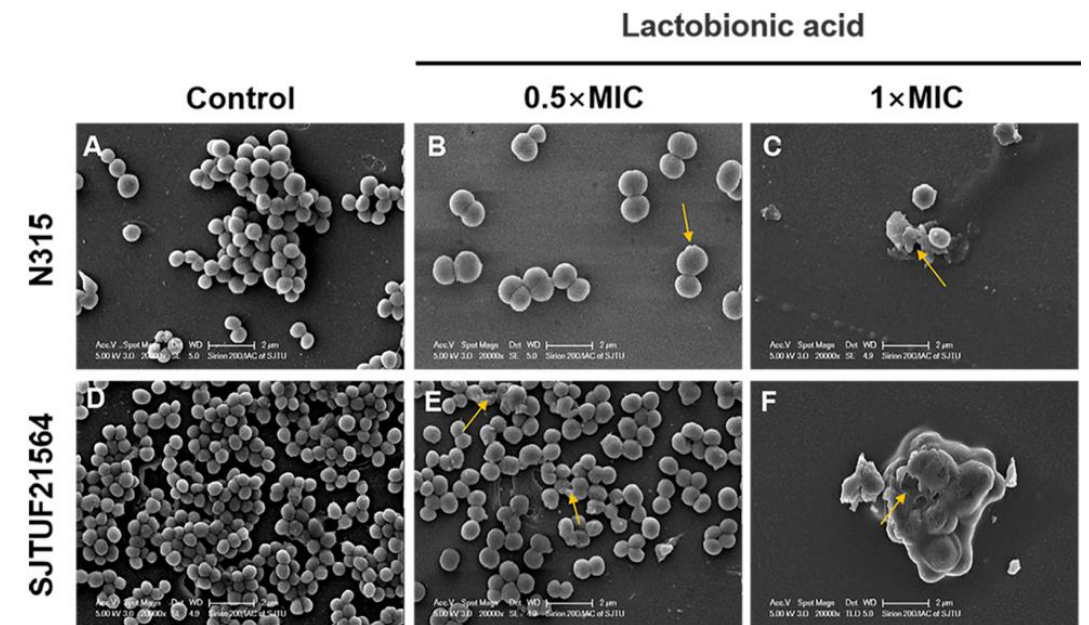
Figure 4. SEM images of biofilm formation of S. aureus inhibited with LBA at different concentrations. ( A , D ) are the controls, ( B , E ) are induced with 0.5 × MIC, and ( C , F ) are induced with 1 × MIC. Yellow arrows show disrupted cells.